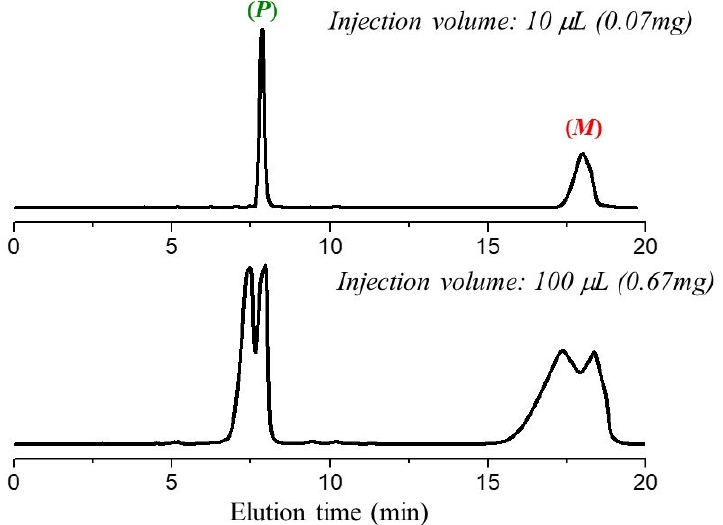
Figure 3. Elution profiles of BT2 – T6 for different sample loads. Chromatographic conditions: column, Chiralpak IB (250 × 10 mm, 5 μ m); mobile phase, n ‐ hexane–methanol–dichloromethane 90:5:5 ( v / v / v ); column temperature, 15 °C; flow rate, 5.5 mL min − 1 ; detection, UV at 360 nm.